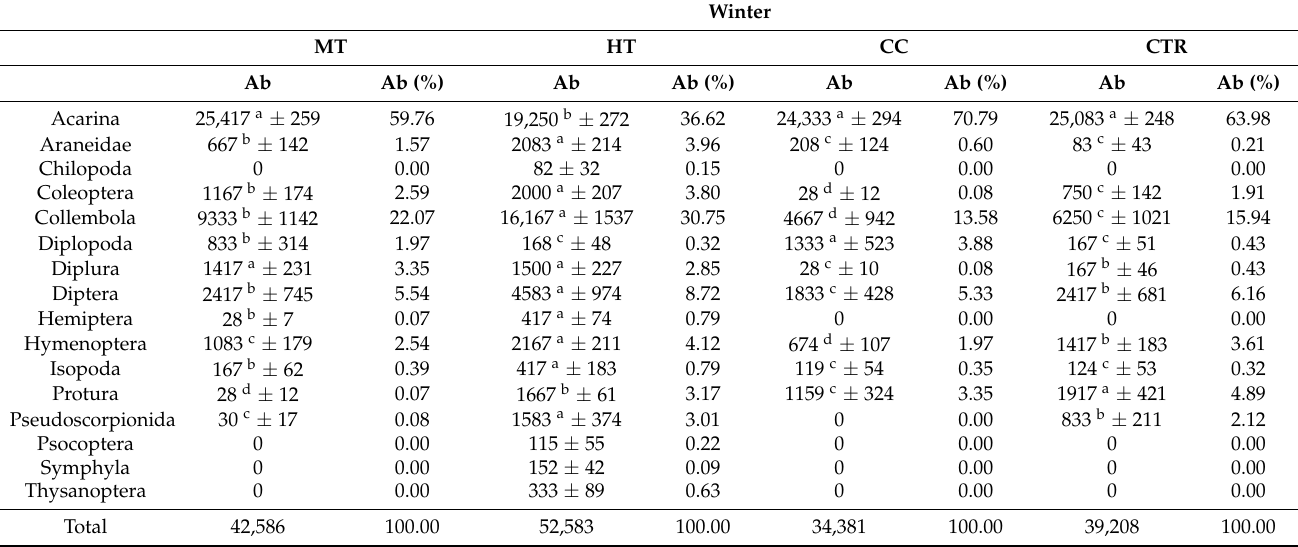
Table 4. Total number of individuals (Ab) and percentage abundance (% Ab) of arthropods captured in winter in soil under differently managed plots of a Pinus laricio stand. HT: intensive thinning; MT: moderate thinning; CC: clear cut; and CTR: control. The data are the means of two consecutive years (2014 and 2015). Different letters, in the same row, show significant differences at p ≤